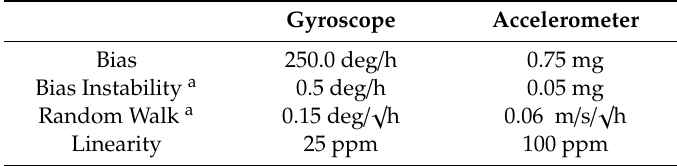
Table 1. STIM-300 Micro-Electro-Mechanical Systems (MEMS) specifications.